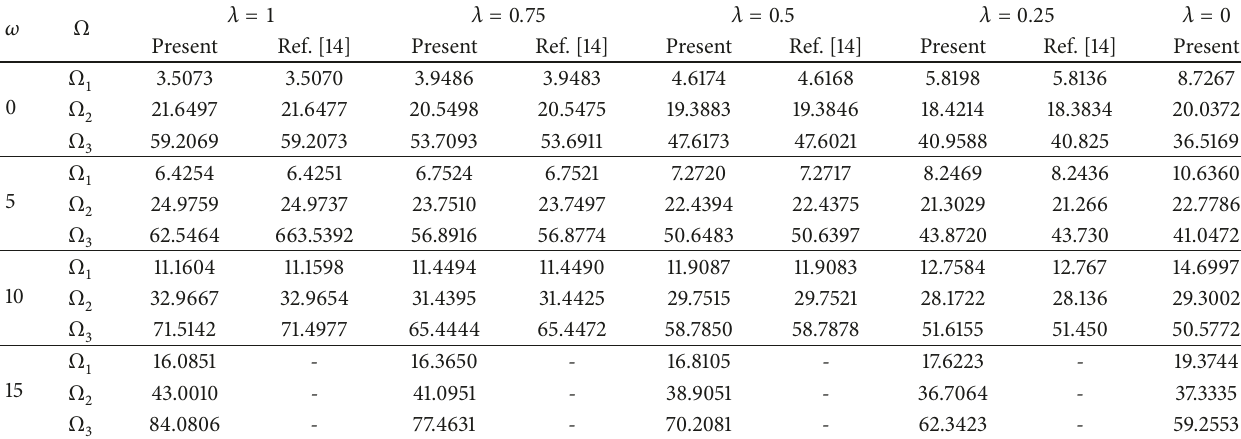
Table 2: Comparison of the first three dimensionless natural frequencies of rotating solid tapered Rayleigh beams for different 𝜆 (0 ≤ 𝜆 ≤ 1) at 𝑟 0 = 0 , 𝛽 = 0 , 1/𝑟 = 30 .